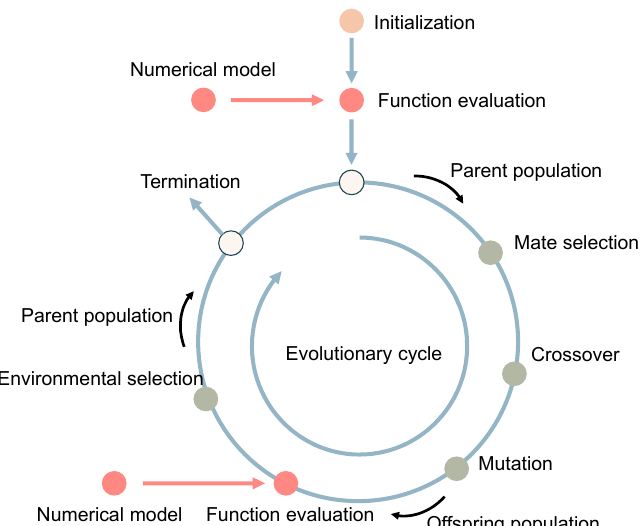
Figure 1. The flow chart of the traditional simulation-optimization method.